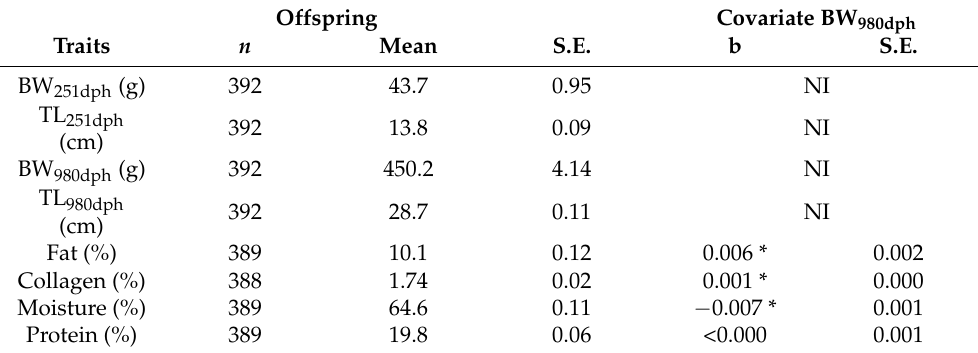
Table 2. Phenotypic results (least square means ± standard error) for body weight, fork length, and flesh composition for gilthead seabream.